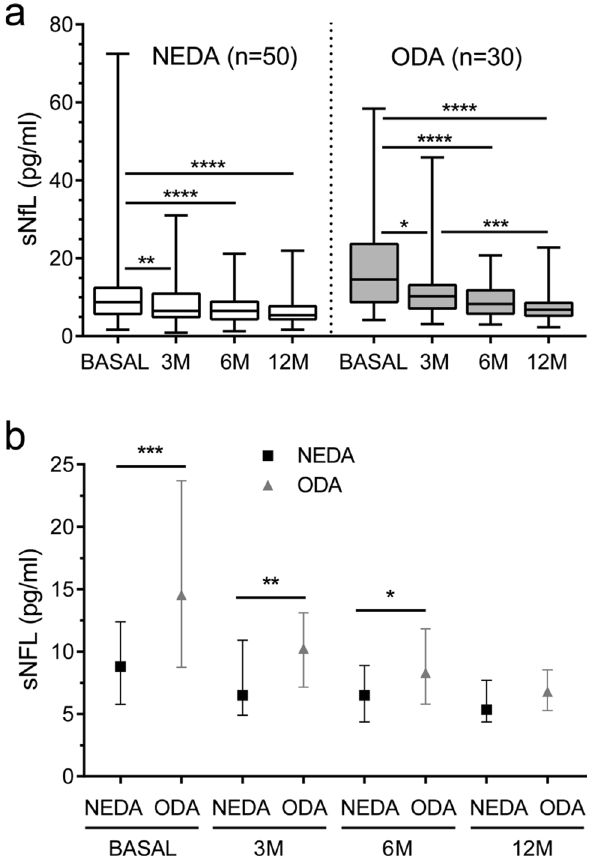
Figure 2. Serum neurofilament light chain (sNfL) values in NEDA and ODA patients. ( a ) sNfL levels (median, IQR) of NEDA (white rectangle; n = 50) and ODA (grey rectangle; n = 30) relapsing–remitting multiple sclerosis patients at baseline (basal) and at 3, 6, and 12 months (M) of dimethyl fumarate treatment initiation. ( b ) Differences in sNfL values (median, IQR) between NEDA (black square) and ODA (grey triangle) patients at each time point. Only p values below 0.05 are shown. * p < 0.05; ** p < 0.01; *** p < 0.001; **** p < 0.0001. NEDA no evidence of disease activity, ODA ongoing disease